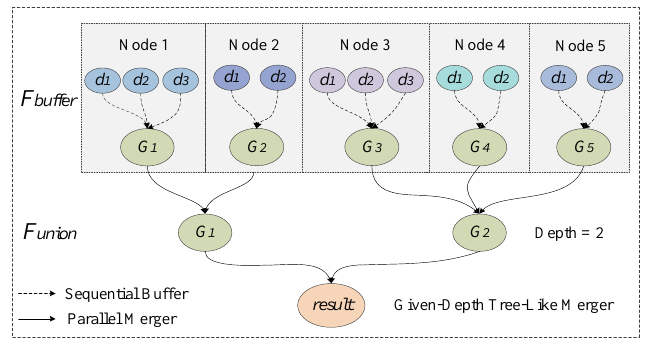
Figure 7. Depth-given tree-like merger